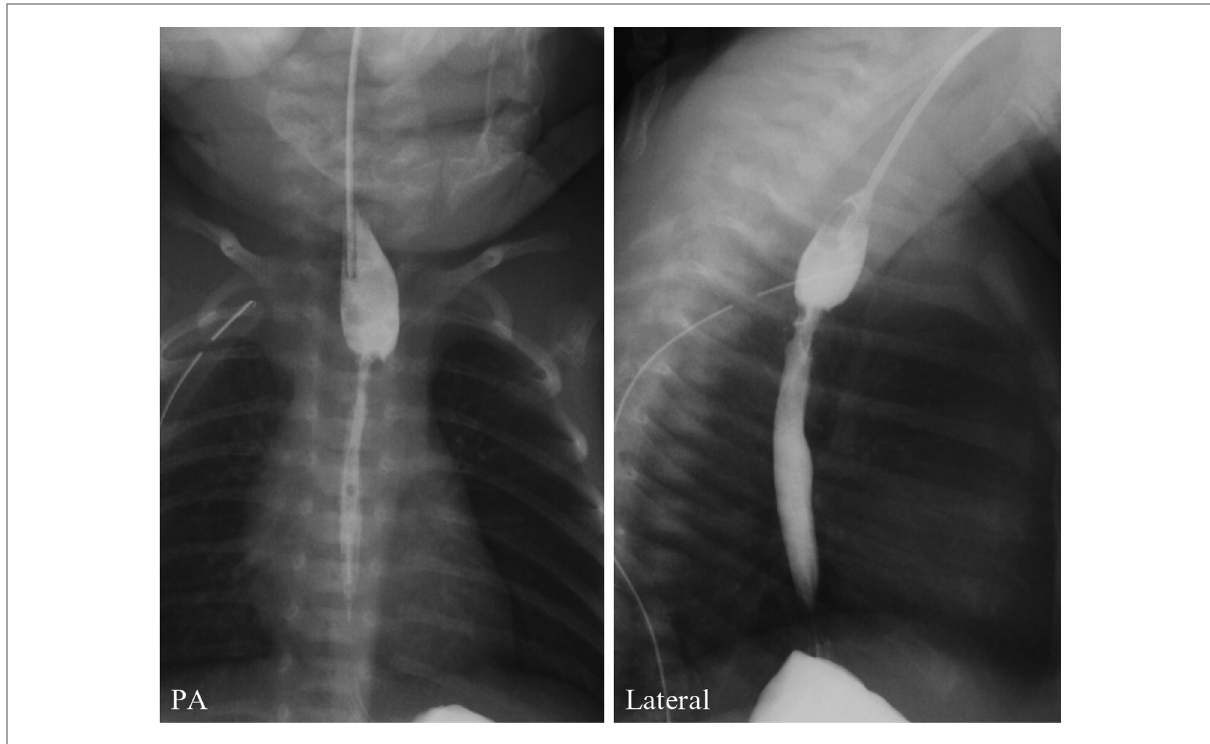
( Figure 1 ), and the patient was discharged on postoperative day (POD) 31 without any